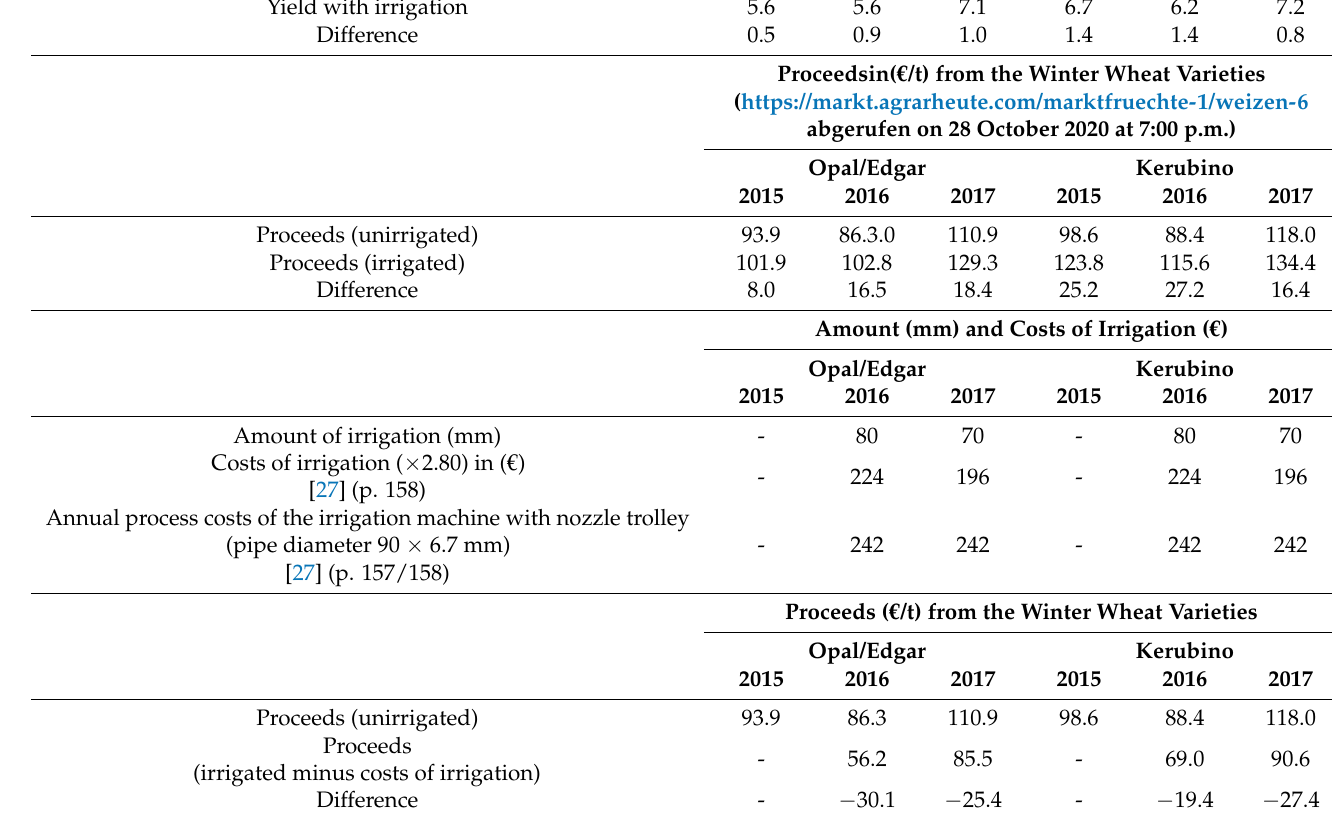
Table 8. p -values of multiple linear regression at the time of measurement between the biometric parameters and the grain yield of winter wheat varieties on irrigated plots 2016 ( p < 0,05: significant, marked red).